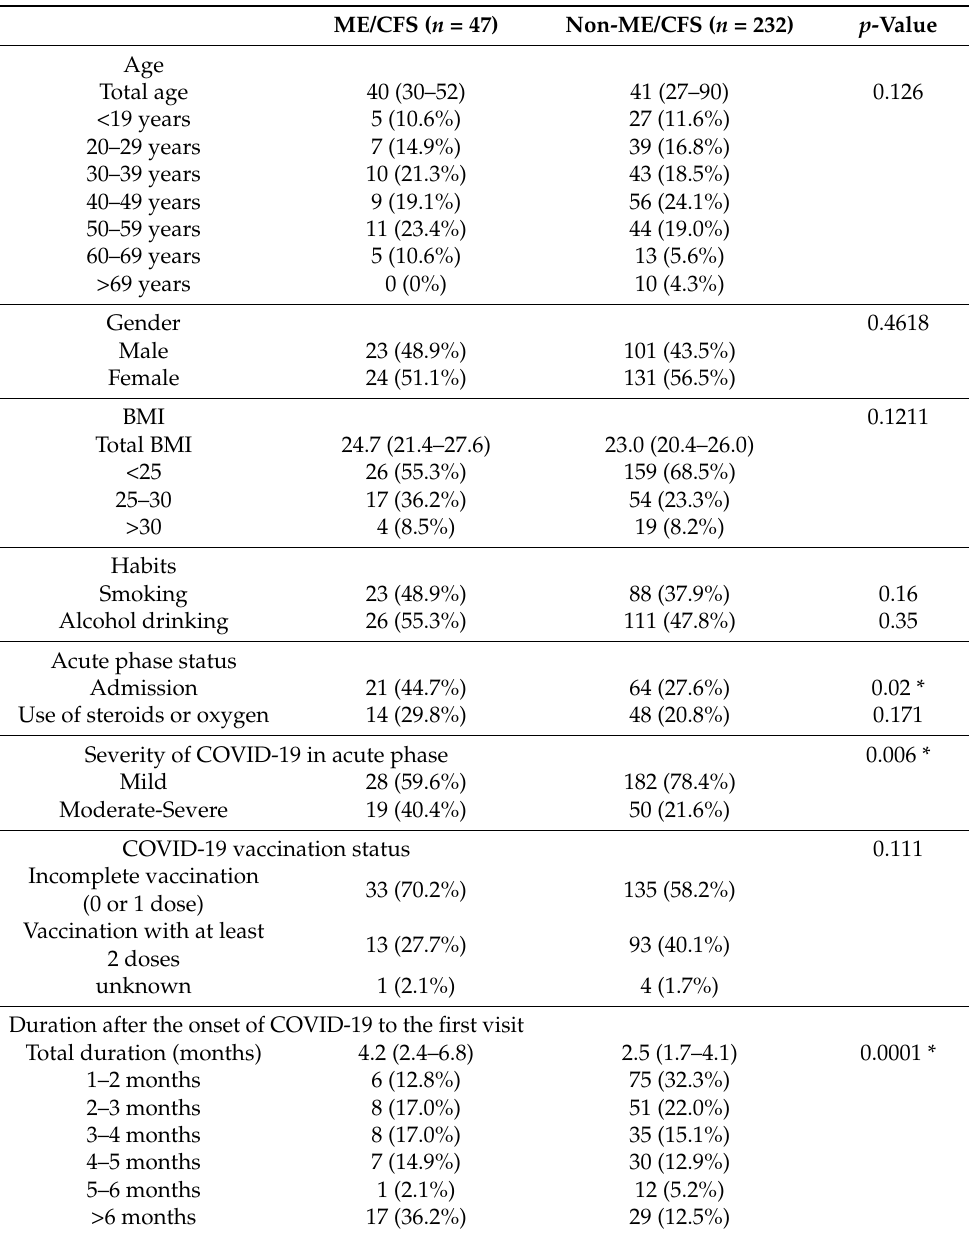
Table 2. Backgrounds of ME/CFS and non-ME/CFS patients who visited the COVID-19 aftercare outpatient